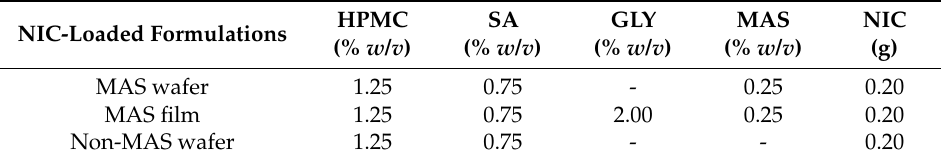
Composite HPMC–SA wafers and films used for this study. NIC: nicotine; HPMC: hydroxypropylmethylcellulose; SA: sodium alginate; GLY: glycerol; MAS: magnesium aluminium